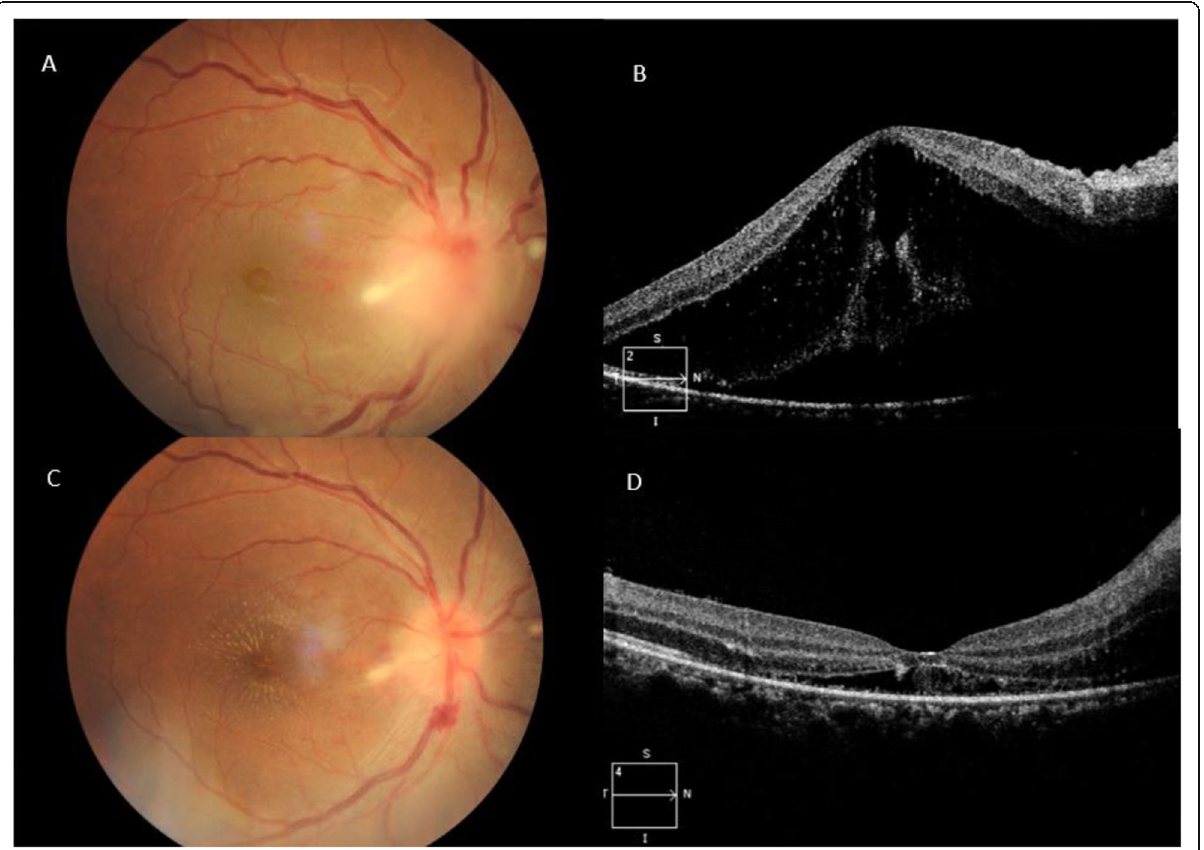
Fig. 6 Patient no. 7. a Colour fundus photograph of the right eye on initial presentation: swollen optic disc, macula oedema, peripapillary RNFL haemorrhages, yellow-white deep retinal lesions near the disc and venous engorgement. VA was 1/60. b Corresponding SD-OCT of the right eye: prominent IRF and SRF with loss of foveal contour. c Colour fundus photograph of the same eye after 2 weeks: resolving optic disc oedema and decrease in venous engorgement and tortuosity. d Corresponding SD-OCT of the same eye 2 weeks later: restoration of the foveal contour, IRF has resorbed with some residual SRF. VA improved to